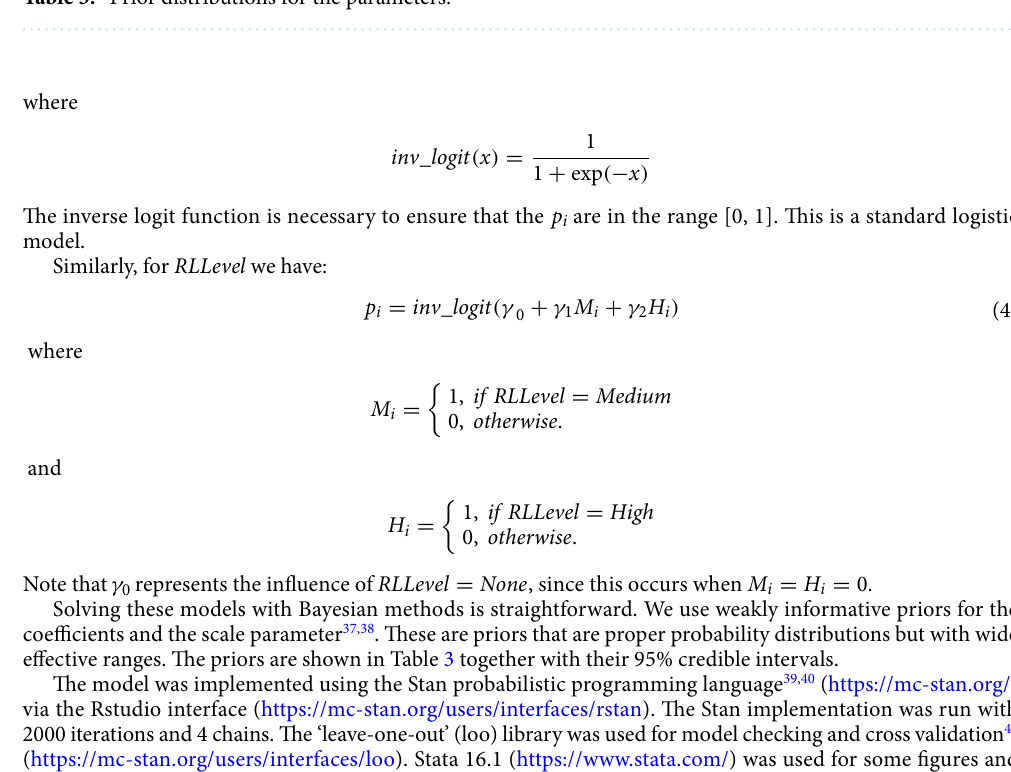
Table 3. Prior distributions for the